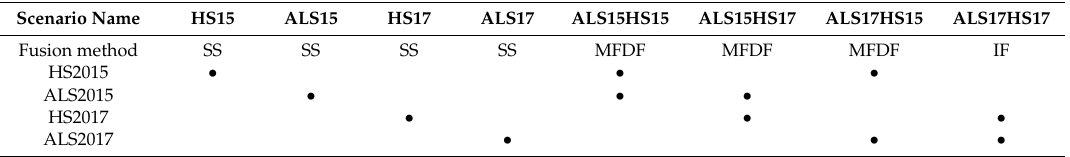
Table5. Setsofrasterdatausedinindividualclassificationscenarios.